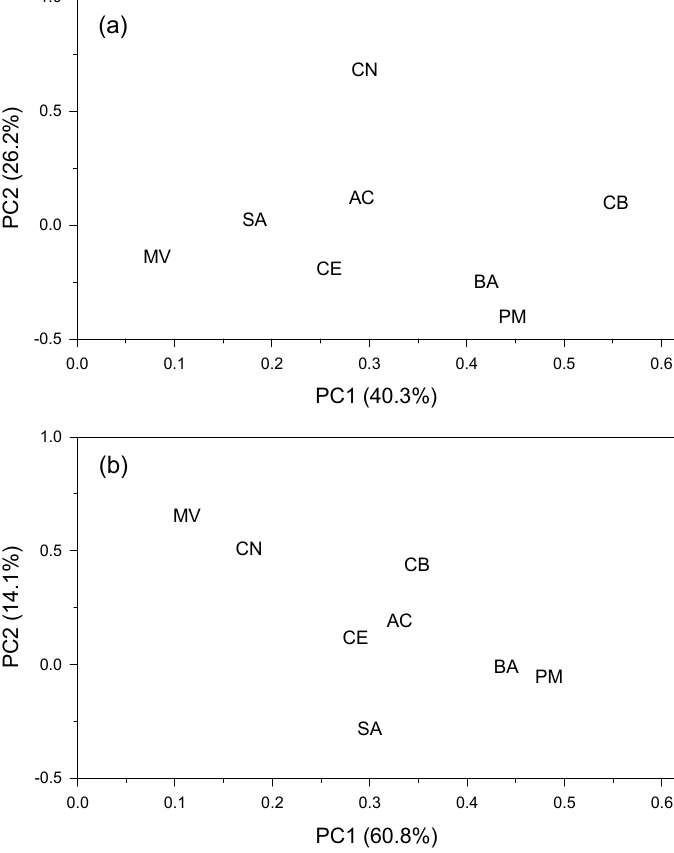
Figure 3. Biplots showing the scores in the first (PC1) and second (PC2) principal components of principal component analyses calculated on the matrix of ( a ) site chronologies (common period 1982–2011) and ( b ) climate–growth Pearson correlations of Atlas cedar plantations. Sites’ codes: MV, Valliguières; CN, Berriozar; SA, Sariñena; CB, Bañón; AC, Monte Abantos; CE, Monte Mario-Béjar; BA, Baza; and PM, Puerto de la Mora. The plot ( a ) shows the similarity among sites based on site series of ring-width indices, whereas the plot ( b ) shows the similarity among sites based on climate–growth relationships. The percentages of variance explained by PC1 and PC2 are indicated. Climate–growth correlations were obtained by relating the site chronologies with mean monthly maximum and minimum temperatures and total precipitation from prior to current September.